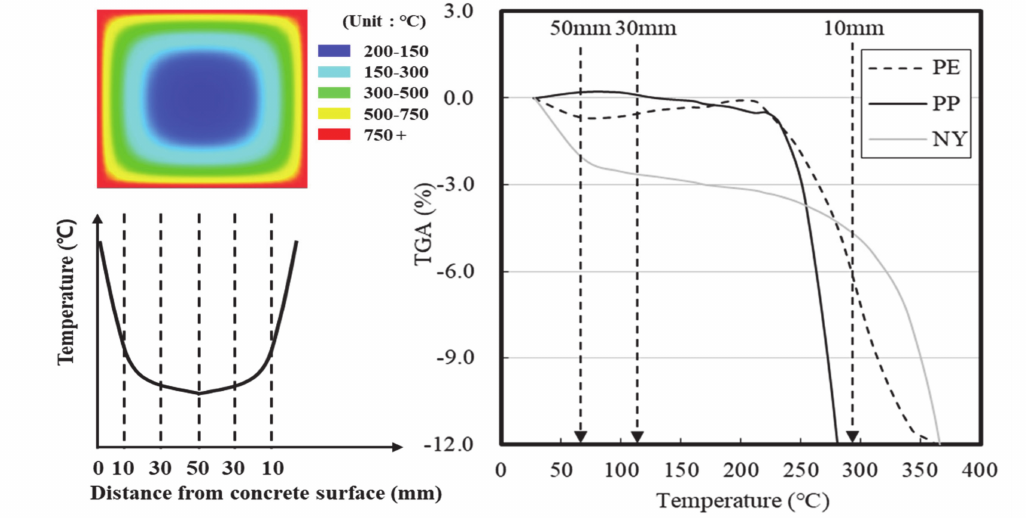
Figure 14. Initial melting properties of the fibers based on the TGA and DTA